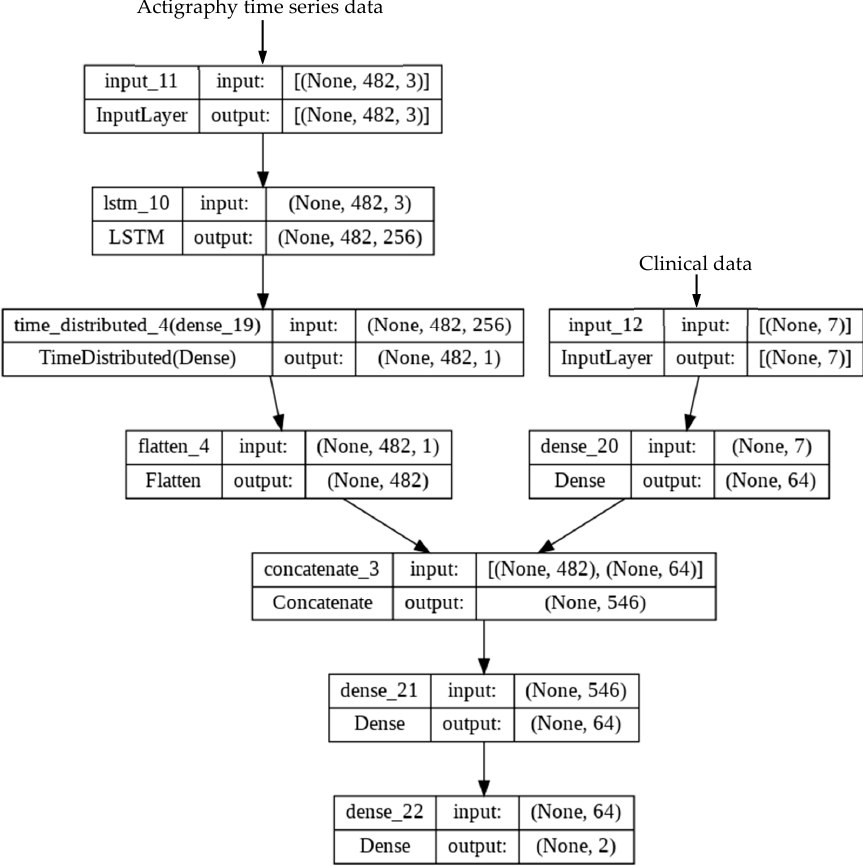
Figure A3. Configuration of LSTM model used for experiment with time series data and clinical data.